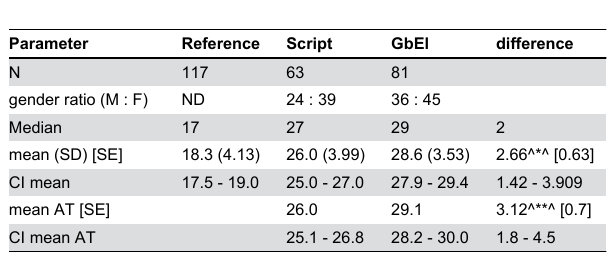
Table 2. ITT-analysis and ITT-adjusted-for-treatment (AT) analysis of the cognitive learning